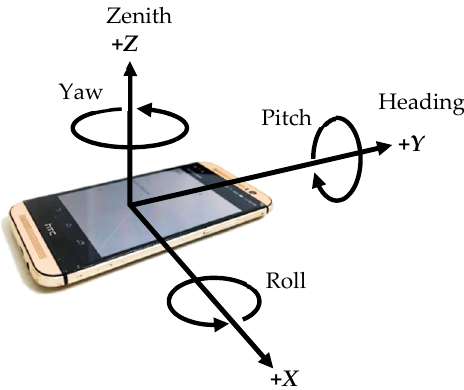
Figure 3. Axial directions of the mobile phone gyroscope.